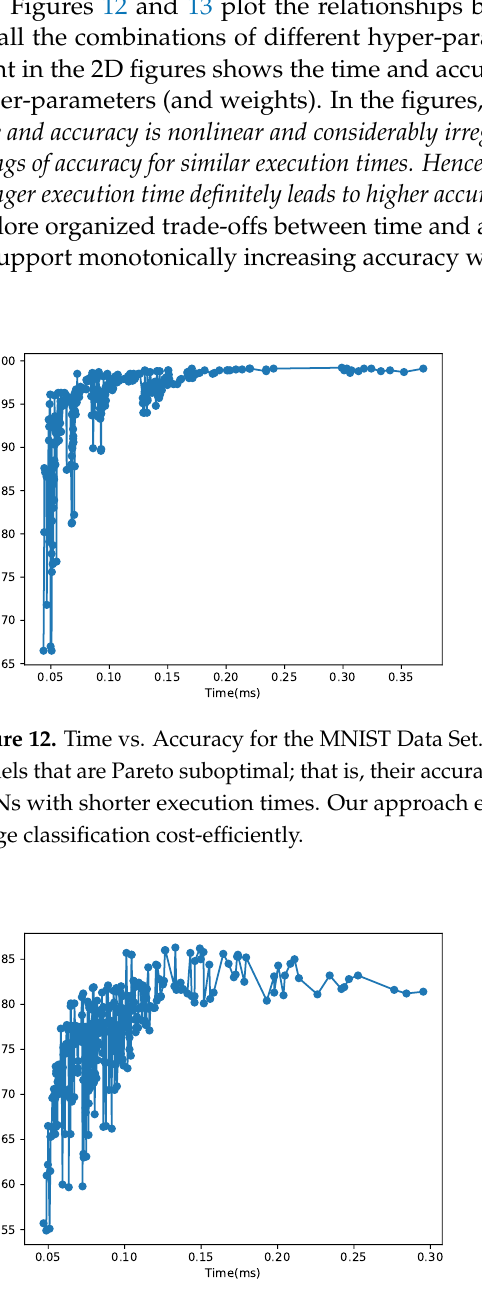
Figure 13. Time vs. Accuracy for the CIFAR-10 Data Set. There are many Pareto suboptimal CNNs for this data set too. Our approach only considers Pareto optimal CNNs as candidates to be included in the set of CNNs for adaptive real-time image classification, H δ P